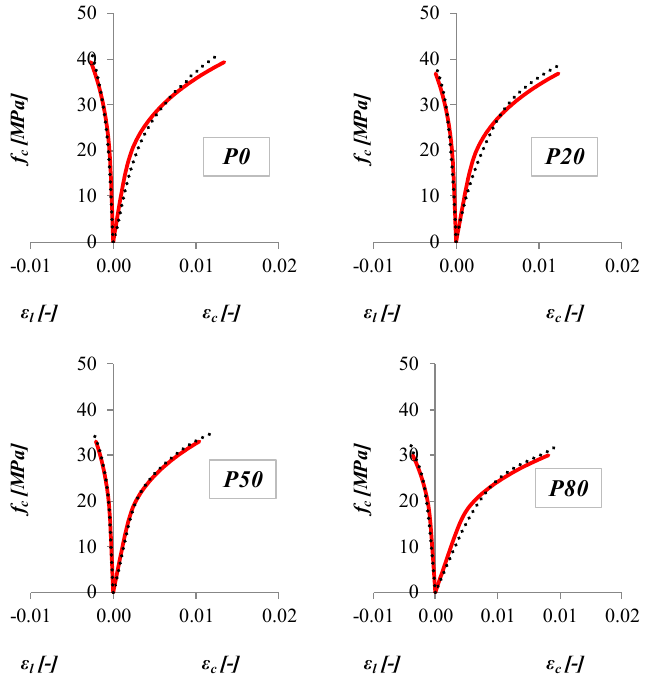
Figure 11. Experimental vs. theoretical comparison (red, theoretical; black, experimental). Table 4. Prediction of the CNR model with modified f c0 values.